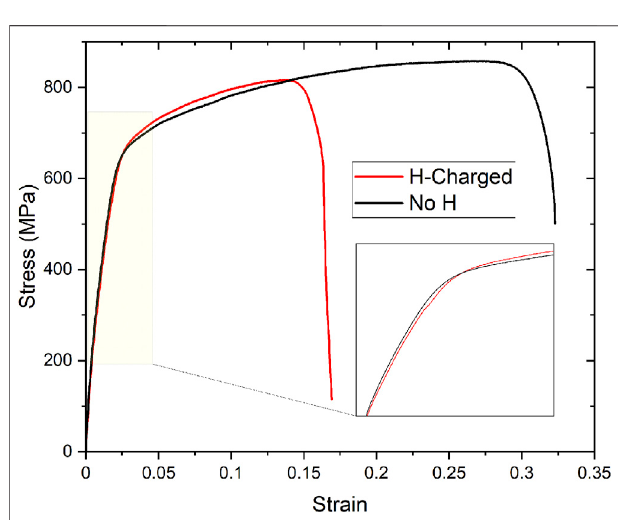
FIGURE 11 | Stress-strain behaviour of the tested super duplex stainless steel without and with pre-hydrogen charging for 10 h with − 38 mA/cm 2